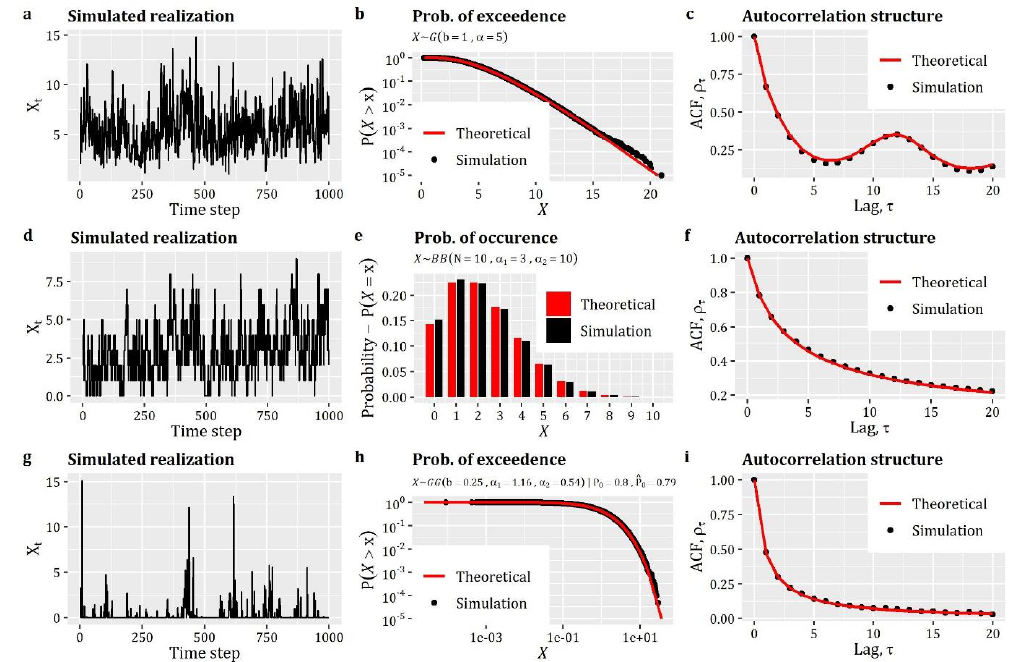
Figure 2. Simulation of univariate stationary processes with: (first row, a – c ) continuous distribution function; (second row, d – f ) with discrete distribution; and (third row, g – i ) with zero-inflated distribution. The figure displays: (first column, a , d and g ) the simulated realization of the processes; (second column, b , e and h ) the comparison between theoretical and simulated empirical probability plots; and (third column, c , f and i ) the comparison between theoretical and simulated autocorrelation structures.